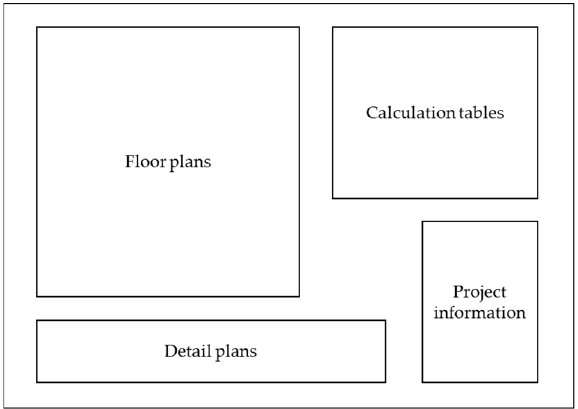
Figure 3. Reference format for the exported plans.